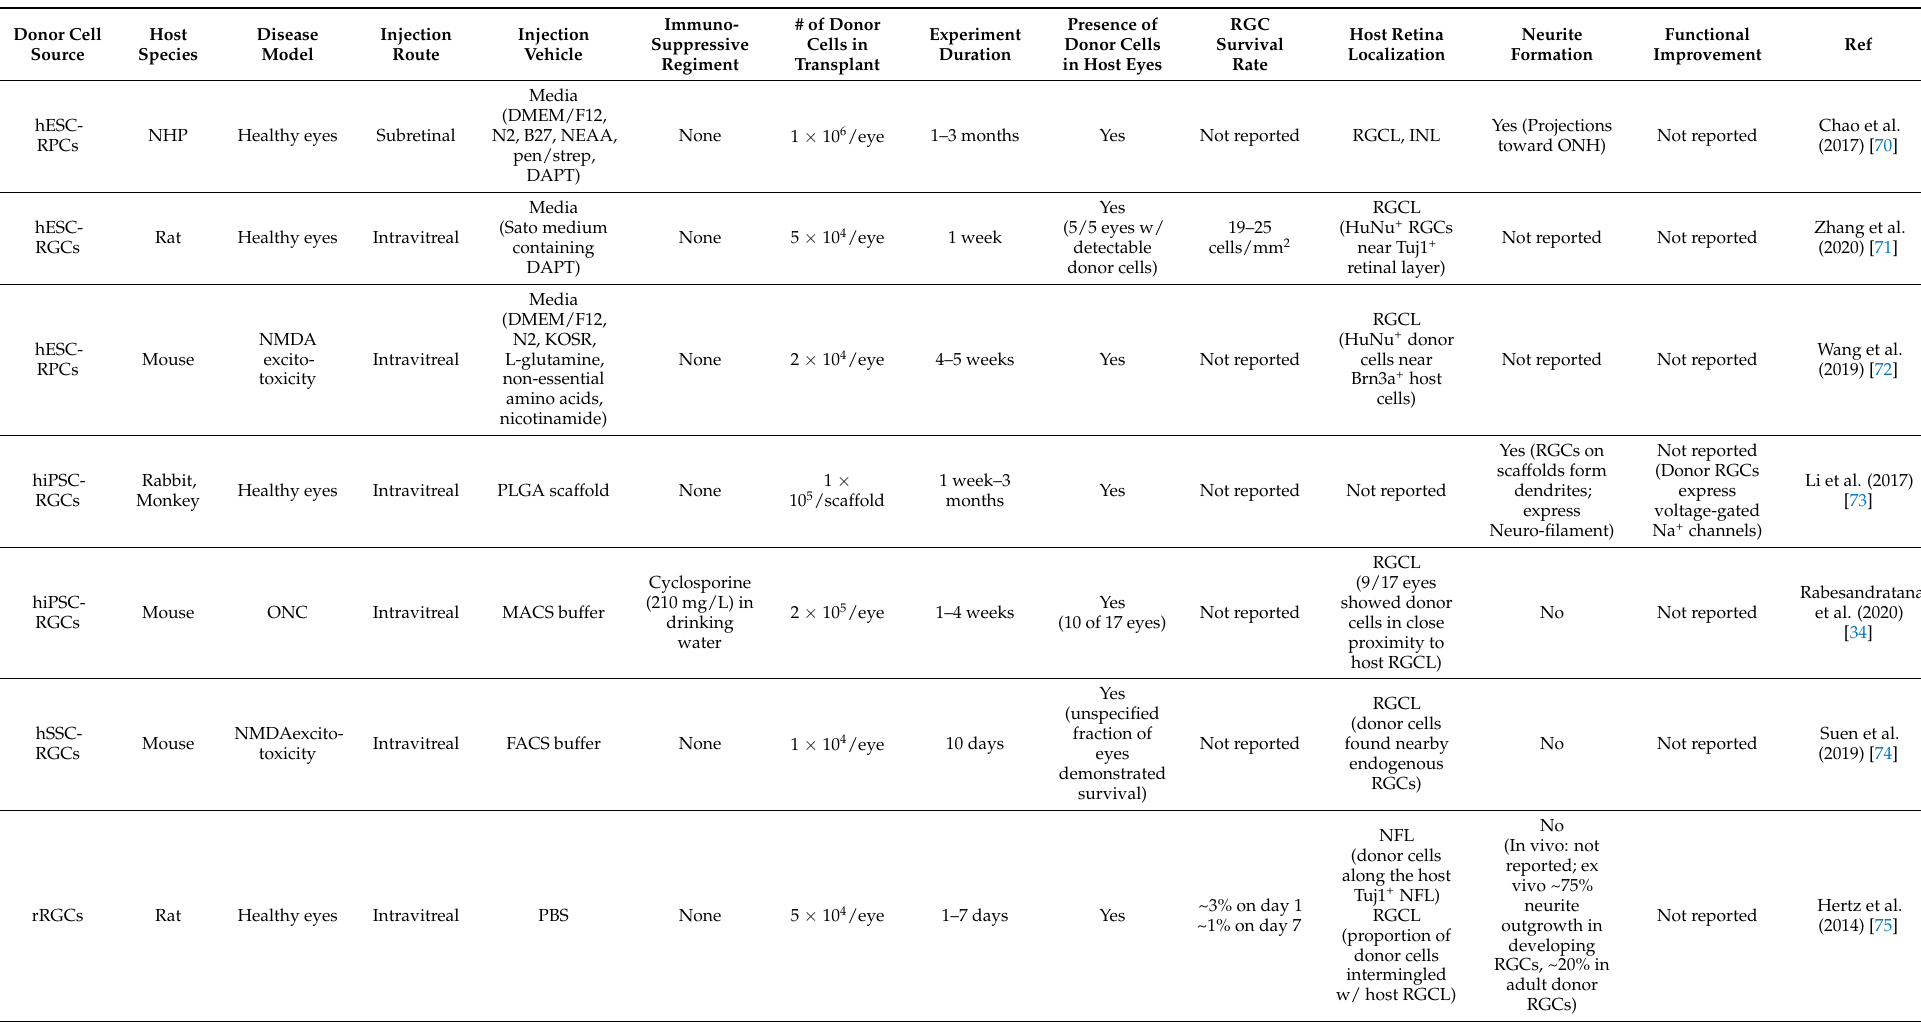
Table 2. Summary of published experimental RGC transplantation